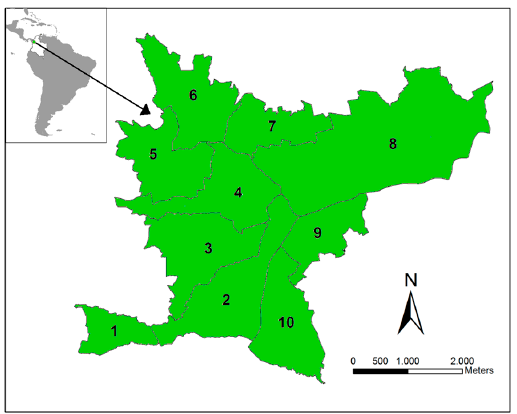
Figure 1. Study site. The Bello municipality is located in Antioquia Department (Colombia). This municipality is divided into 10 main zones in which dengue is endemic.